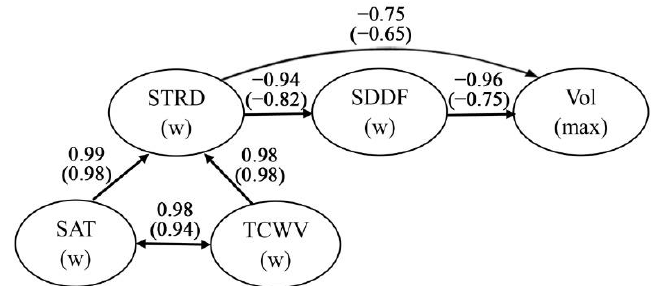
Figure 7. Graph correlations between the characteristics of the atmosphere and sea ice in the Arctic for 1979–2020. The numbers above the arrows are the correlation coefficients between the parameters, which are indicated within the ellipses. In brackets, there is the coefficient between the series with the removed trend.